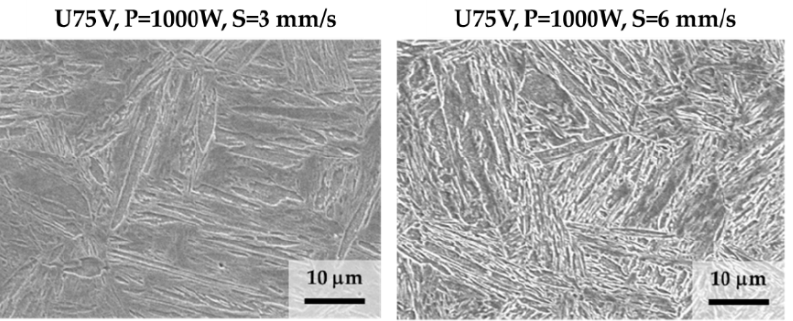
Figure 10. Microstructure of the interface zone between the cladded material and the heat-affected zone of substrate on U75V rail steels with different scanning speeds.